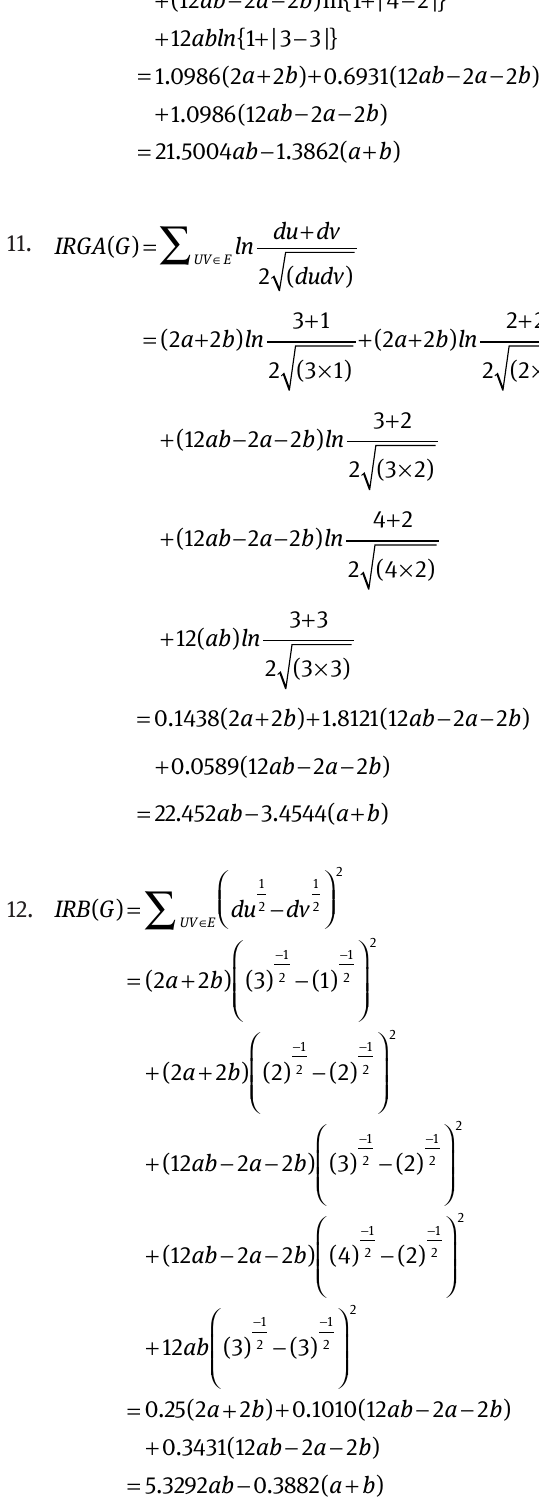
Table 3: Irregularity indices of 2D structure of M1TPyP-M2 metal organic frameworks Irregularity